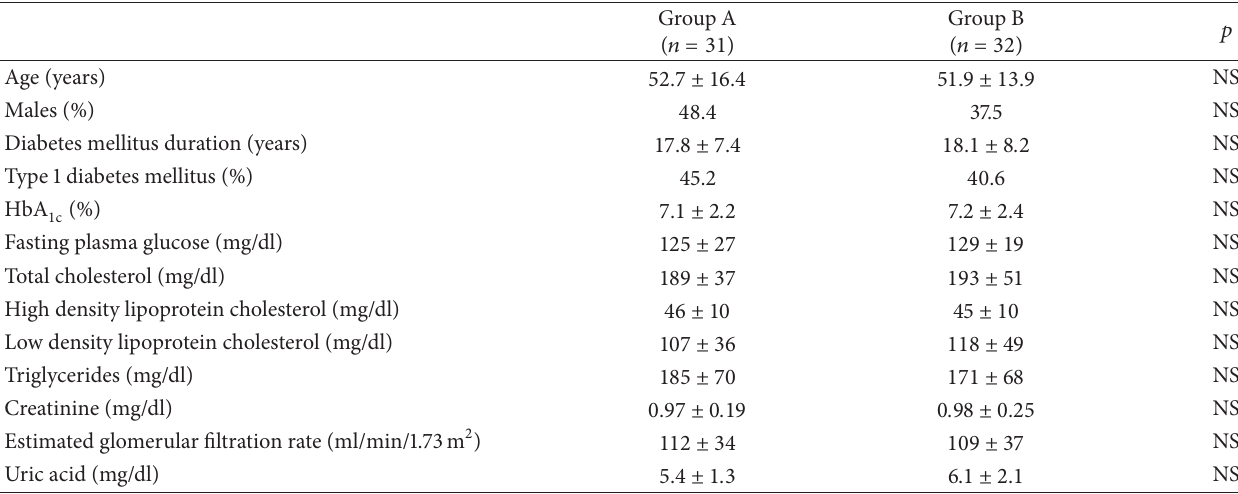
Table 1: Characteristics of patients at